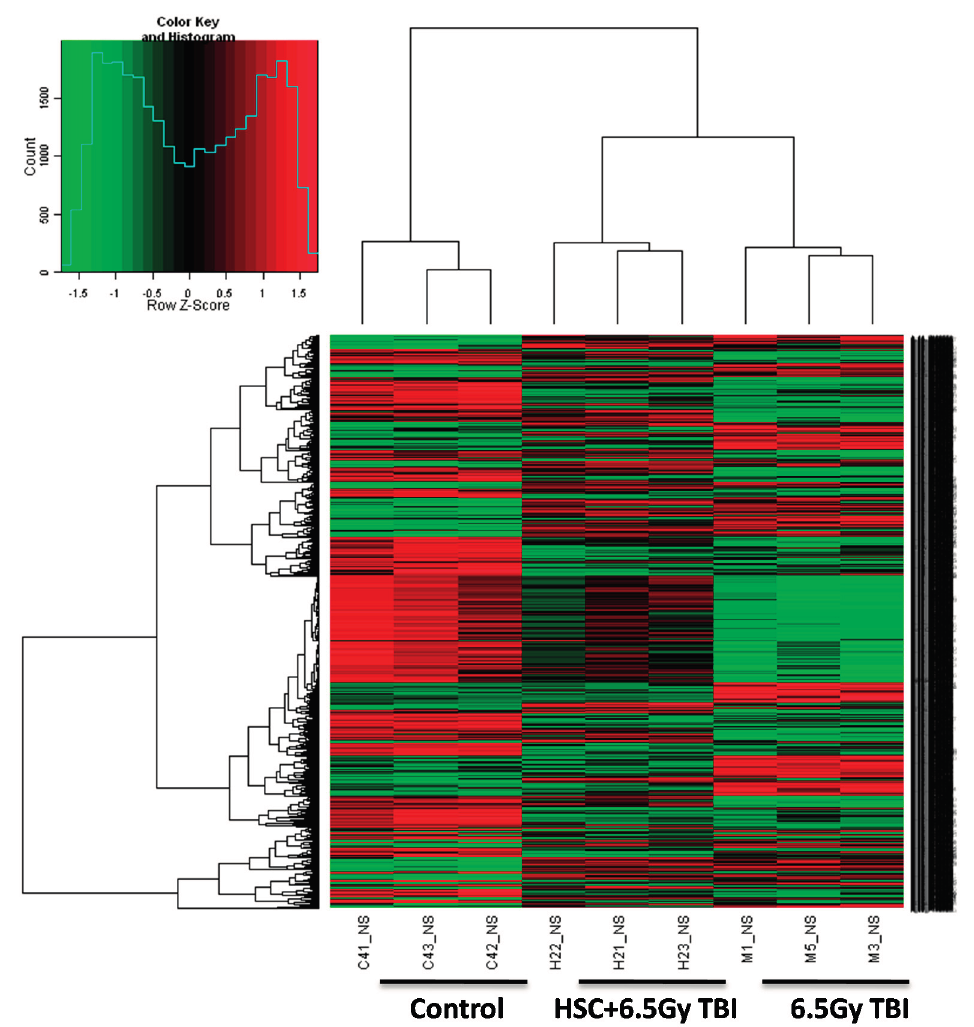
Figure 3. Cluster analysis of individual rats according to the profile of gene expression examined. Genes are organized by hierarchical clustering based on overall similarity in expression patterns. Red represents relative expression greater than the median expression level across all samples, and green represents an expression level lower than the median. Black indicates intermediate expression. Rats from the same treatment group (6.5 Gy TBI, 10 g/kg HSC + 6.5 Gy TBI) were the